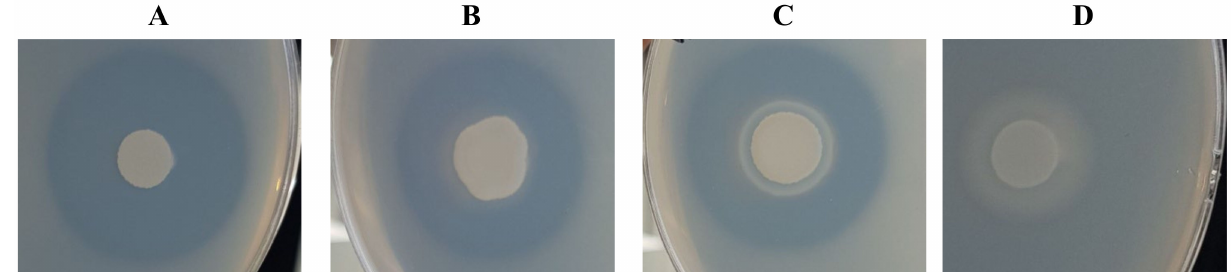
Figure 4. Proteolysis zone observed on the skimmed milk agar plate culture of ( A ) Y. yakushimensis , ( B ) Y. keelungensis , ( C ) Y. alimentaria presented strong proteolytic properties, and ( D ) Y. brassicae of the lower